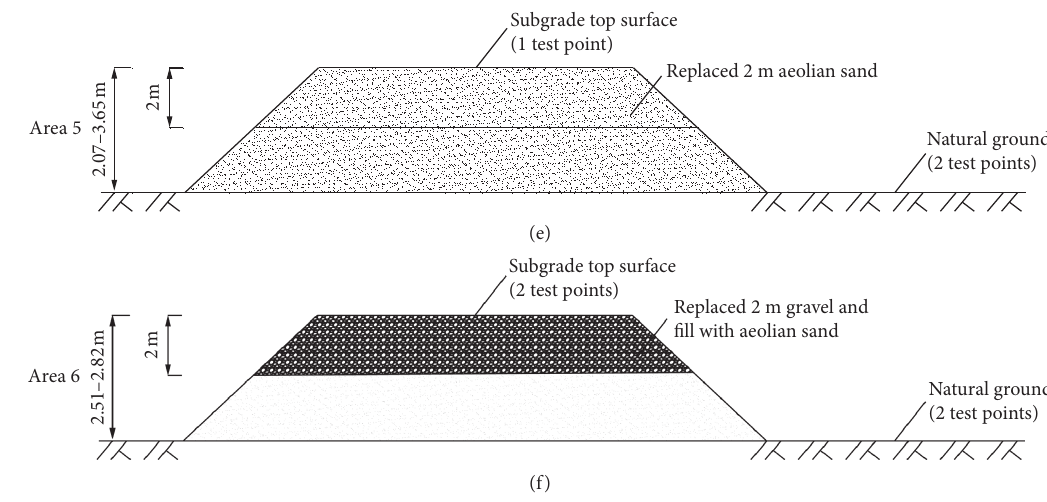
Figure 4: Test points and reinforcement method in each testing